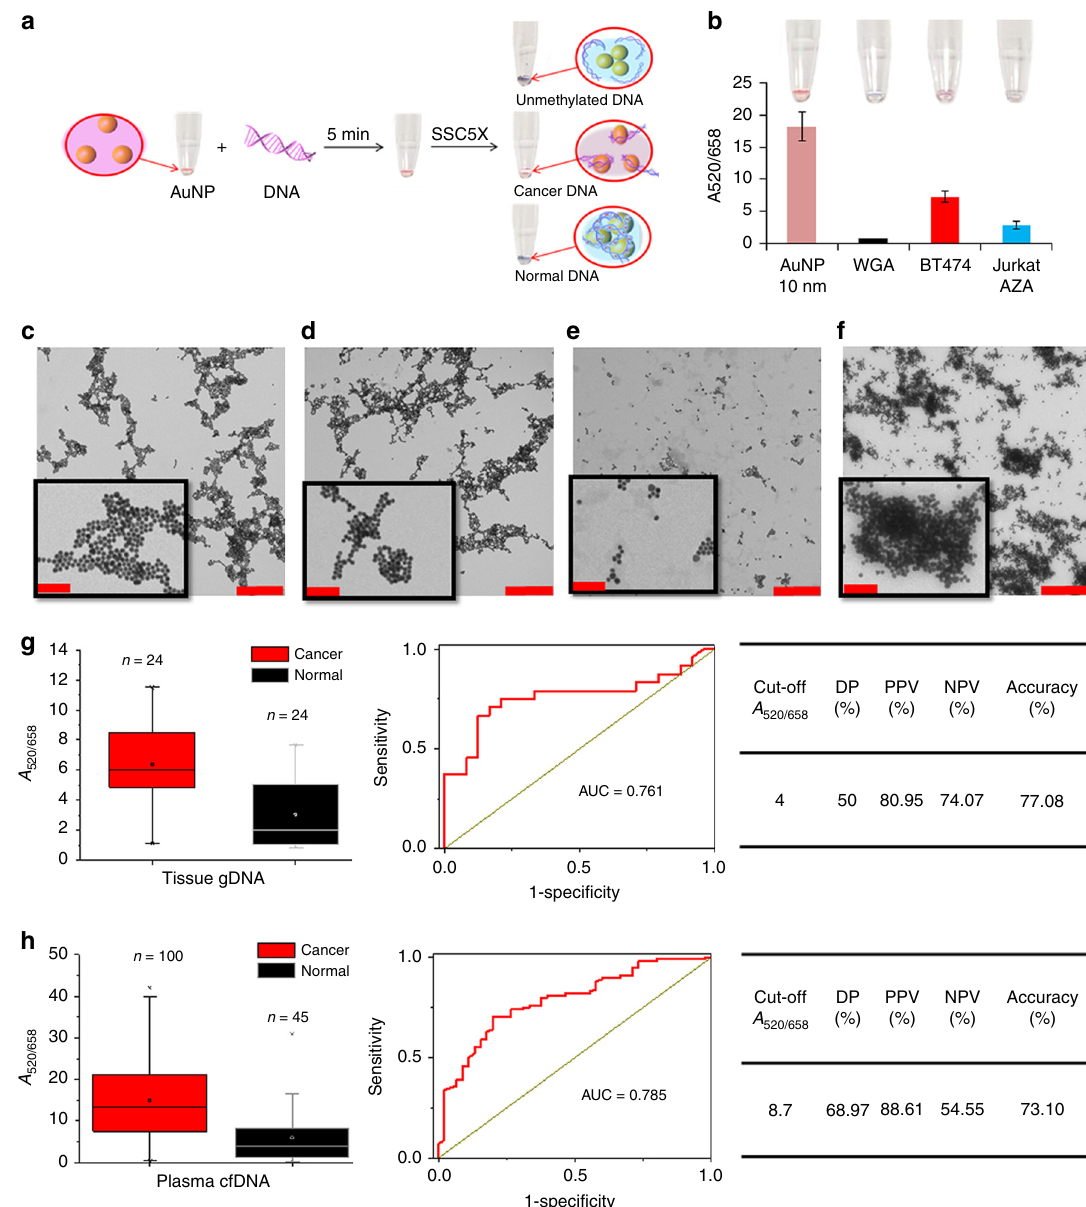
Fig. 4 Naked eye detection of cancer using AuNPs. a Schematic of the assay and proposed mechanism for different DNA types. b Mean relative absorbance values A 520/658 of 10 nm tannic-capped AuNP (pink) and AuNP- gDNA solution for unmethylated WGA (black), BT474 breast cancer cell line (red), and Aza treated Jurkat (light blue). Inset, the representative coloured solution. TEM images of c AuNPs alone, d AuNP-gDNA solution for unmethylated WGA, e AuNP with BT474 cancer DNA and f AuNP with 100% methylated Jurkat DNA (no salt was added during sample preparation, scale bars are 500 nm for normal images and 100 nm for the zoomed images in the black boxes). g Box plot showing the mean relative absorbance values A 520/ 658 of AuNP-gDNA solution for cancer and normal cells extracted from breast, prostate and lymph node tissues, Right: The ROC analysis and diagnostic test evaluation shows the Disease Prevalence (DP), positive predictive values (PPV), negative predictive values (NPV) and accuracy of the method. h Box plot showing the mean relative absorbance values A 520/658 of AuNP-gDNA solution for DNA samples derived from plasma samples of breast and colorectal cancer patients or healthy donors, Right: The ROC analysis and diagnostic test evaluation shows the Disease Prevalence (DP), positive predictive values (PPV), negative predictive values (NPV) and accuracy of the method. In the box and whisker plot, the middle lines of the boxes represent the median (50th percentile) and the terminal line of the boxes represents the 25th to 75th percentile. The whiskers represent the lowest and the highest